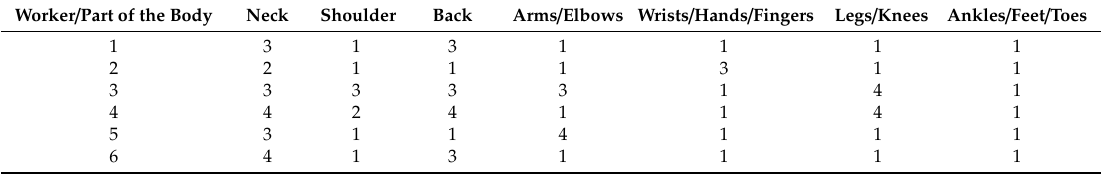
Table 7. Assessment results for the Suzanne Rodgers module for all parts of the body. Worker/Part of the Body